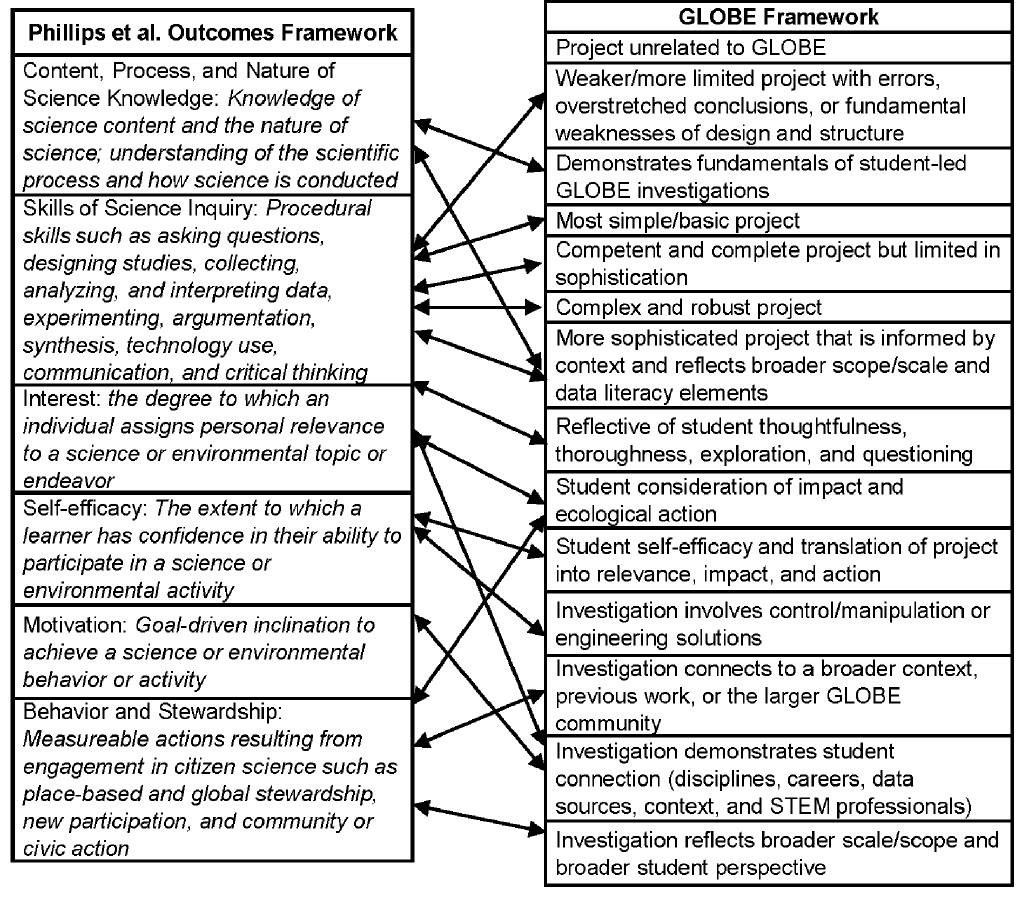
Figure 3 Alignment between the GLOBE citizen science investigation framework and Phillips et al. (2018) framework for individual outcomes resulting from citizen science